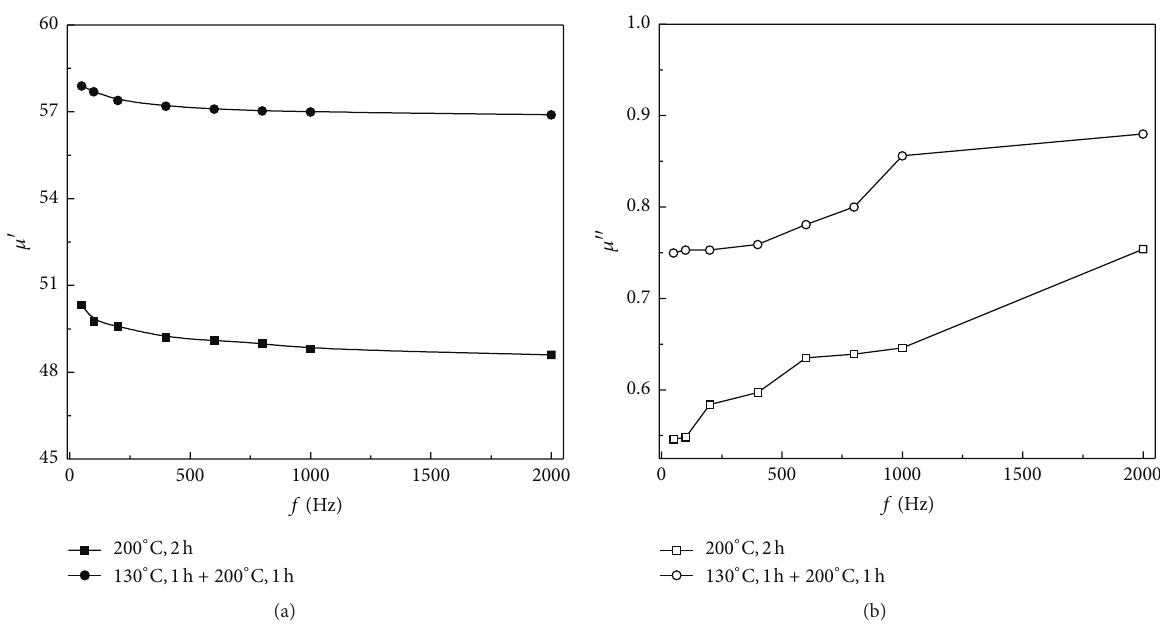
Figure 8: Complex permeability as a function of frequency at 0.7T.